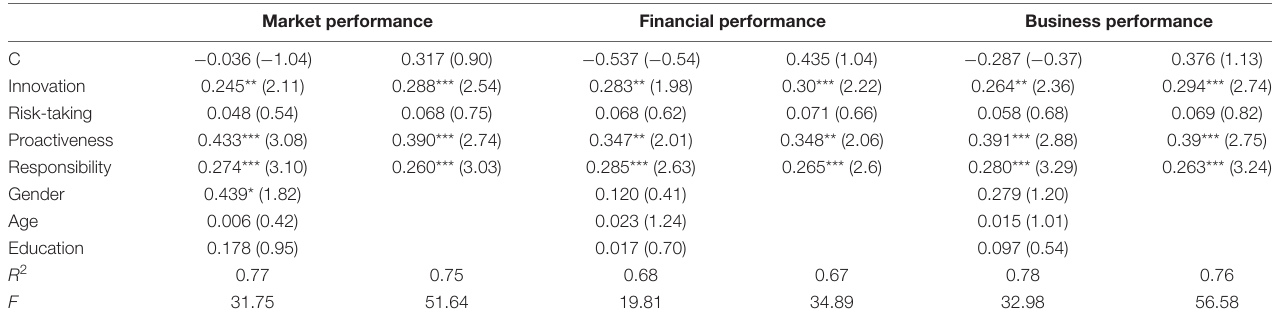
TABLE 4 | Result of the regression